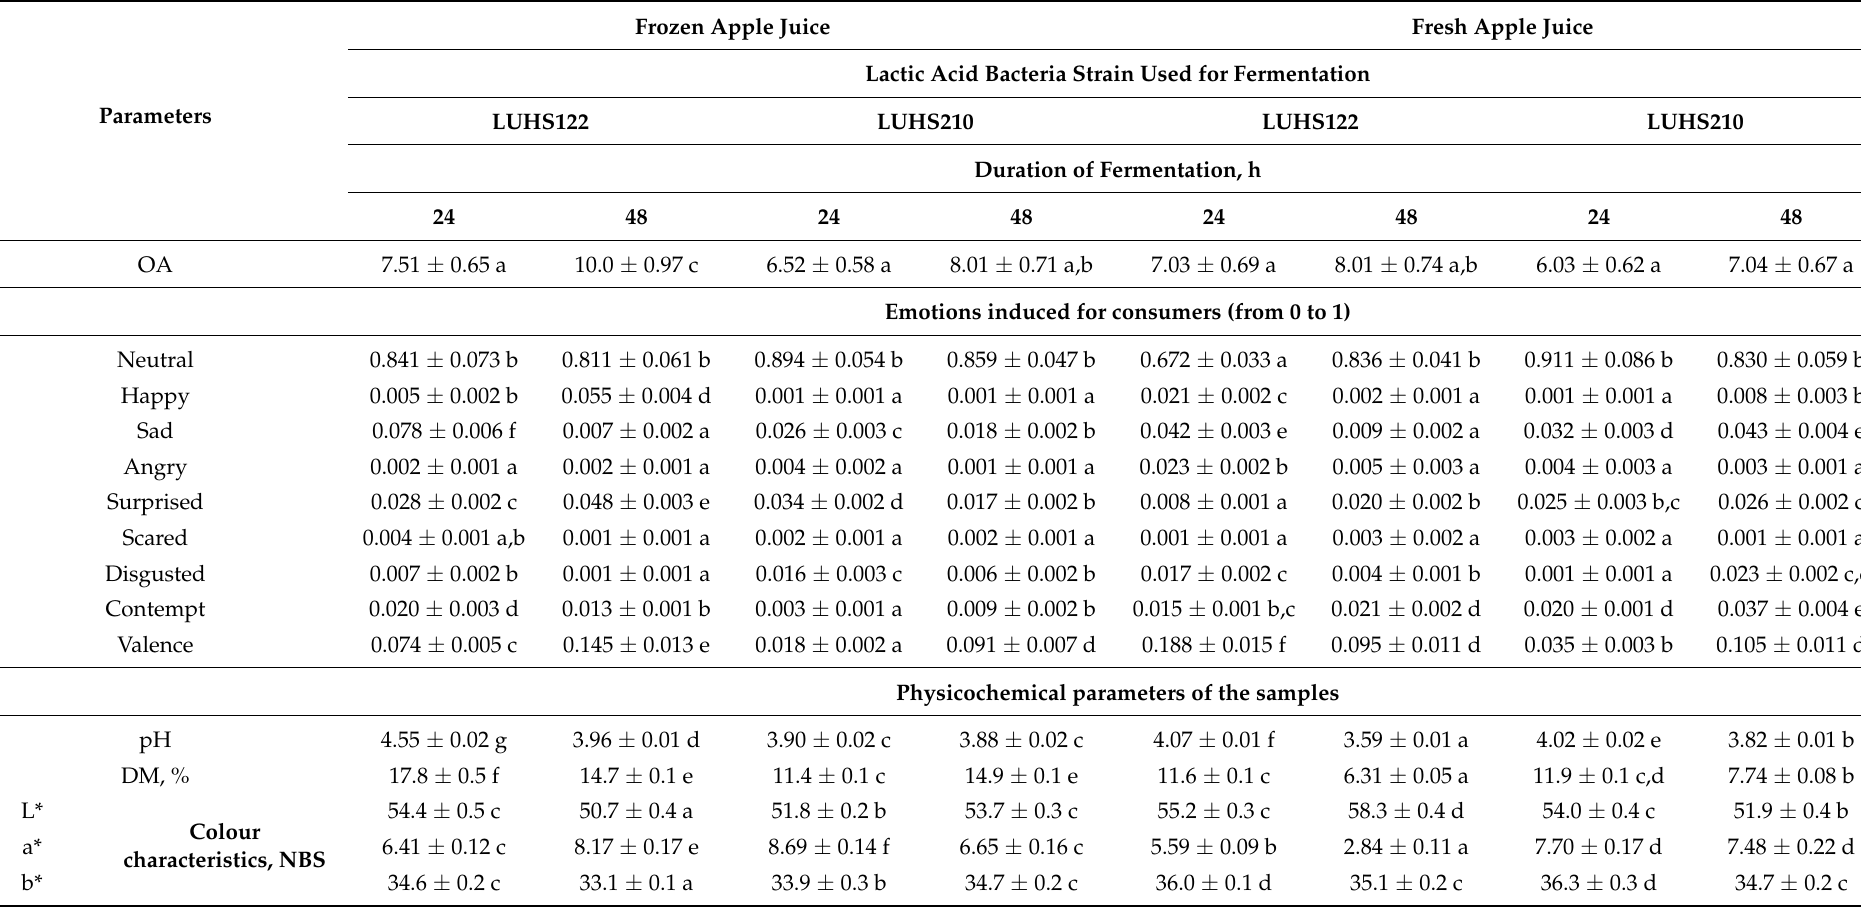
Table 5. Overall acceptability, emotions induced for consumers, and physicochemical properties of fermented apple juice